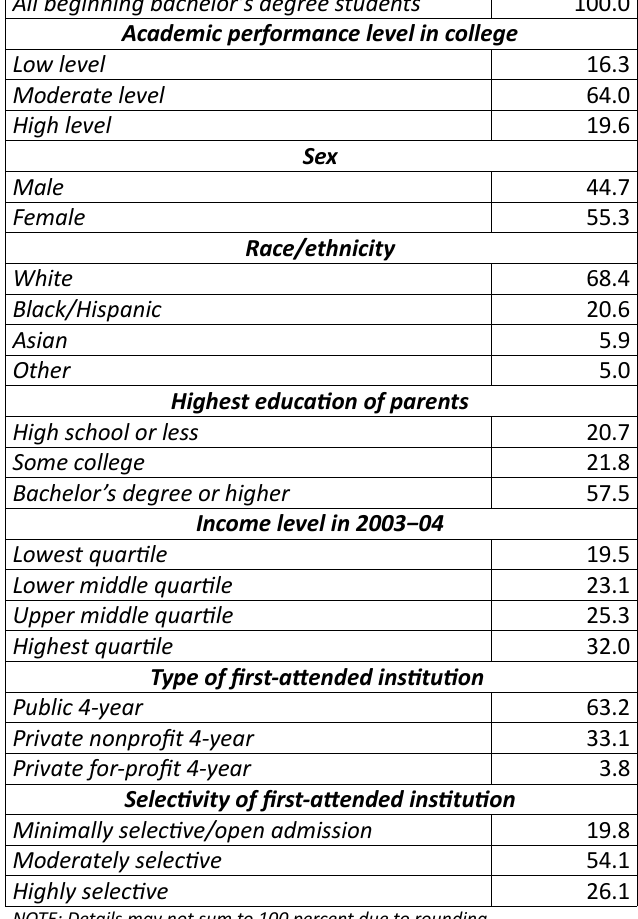
Table 2. Characteristcs of the study